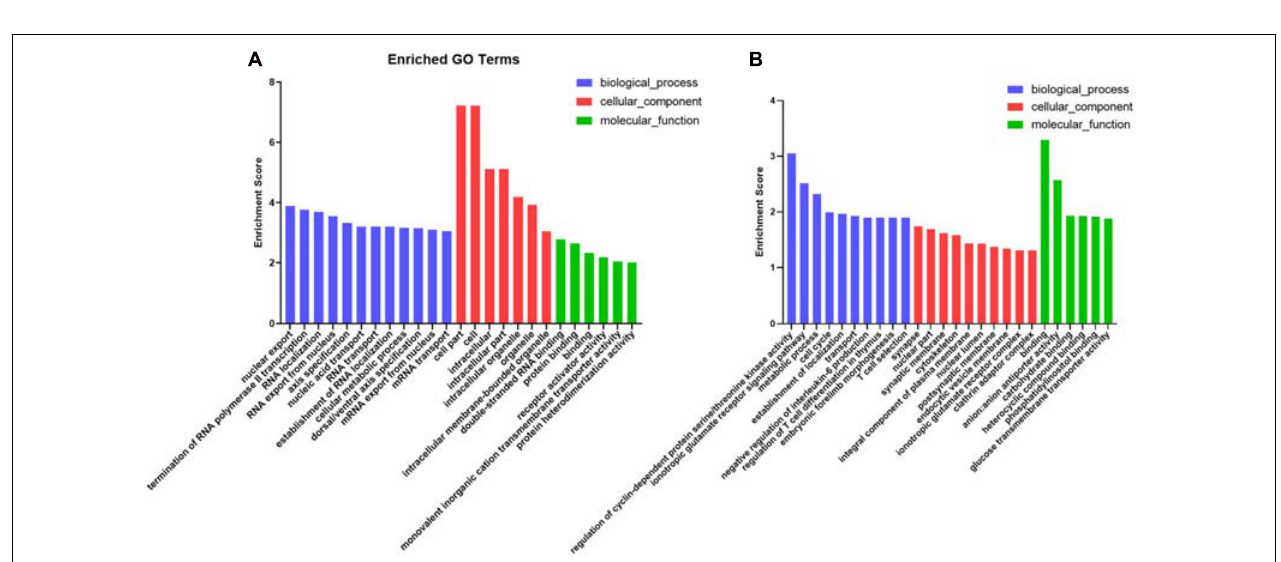
FIGURE 3 | Validation of DE miRNAs by qPCR. Muscle-derived exosome: M-EXO; adipose-derived exosome: A-EXO. ** P < 0.01. Left: Expression of miRNA of sequence data; Right: Expression of miRNA of qRT-PCR.